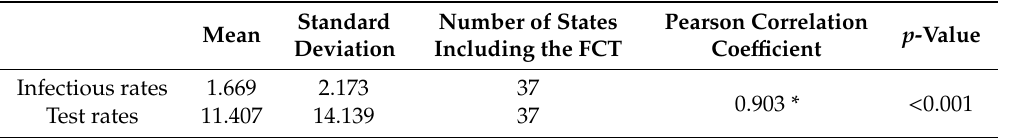
Table 2. Pearson correlation between COVID-19 infectious rates and test rates across 36 states and the FCT in Nigeria. Standard Number of States Mean Deviation Including the FCT